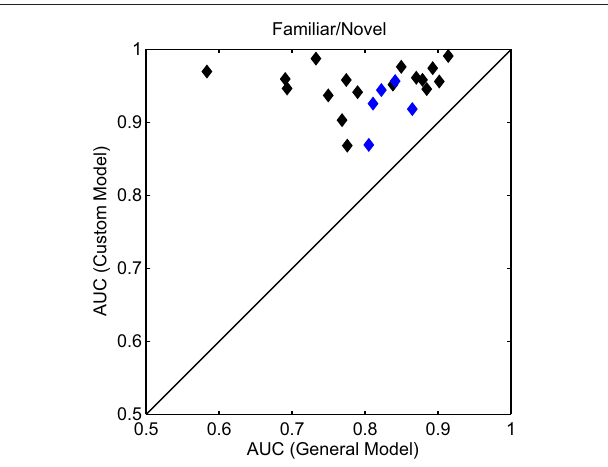
Figure 4 | receiver operating characteristics analysis of classifier performance. Scatter plot of the area under the curve (AUC) for each participant. The x and y axes represent the two comparison conditions: familiar (personal and famous) versus novel and personal versus novel. Red diamonds indicate the individual participants whose ERPs are shown in Figure 5 .